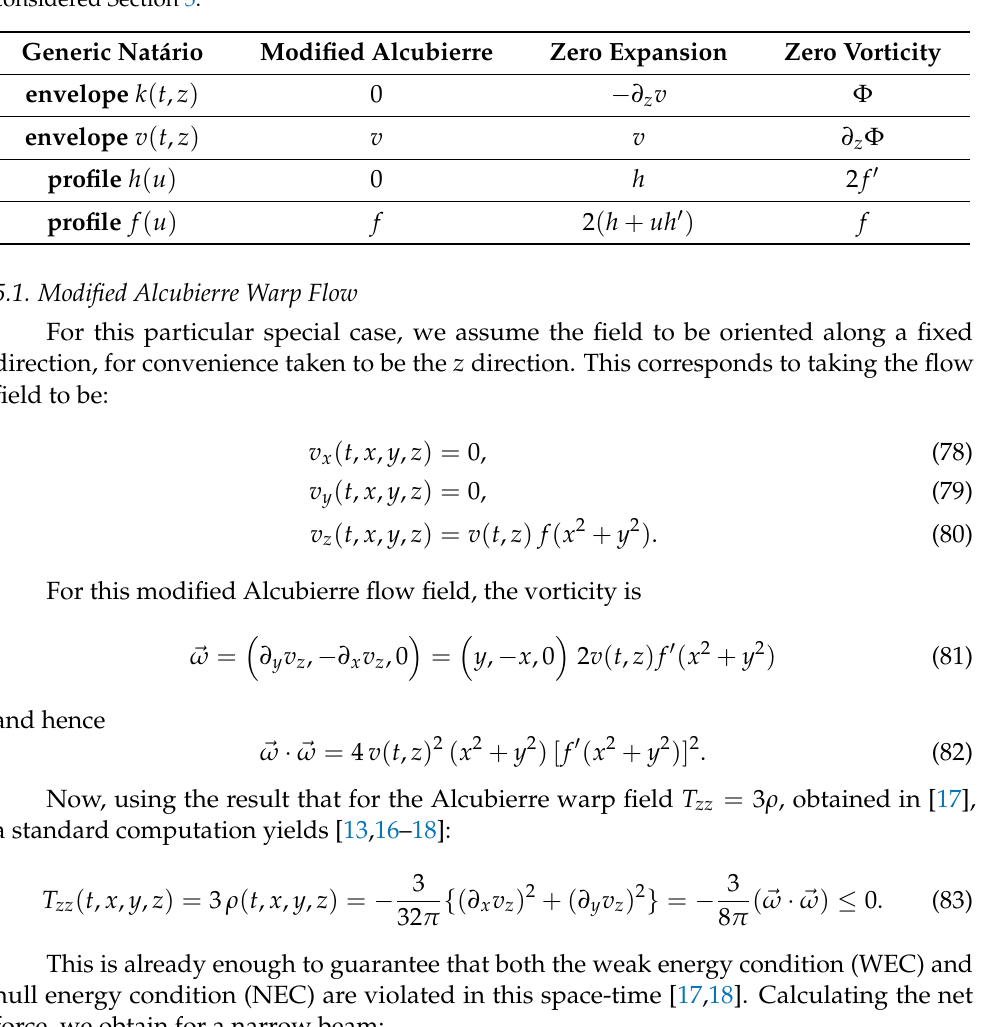
Table 1. A summary of the connections between the generic Natário metric, its envelope functions k and v and its profile functions h and f and the various functions appearing in the special cases considered Section